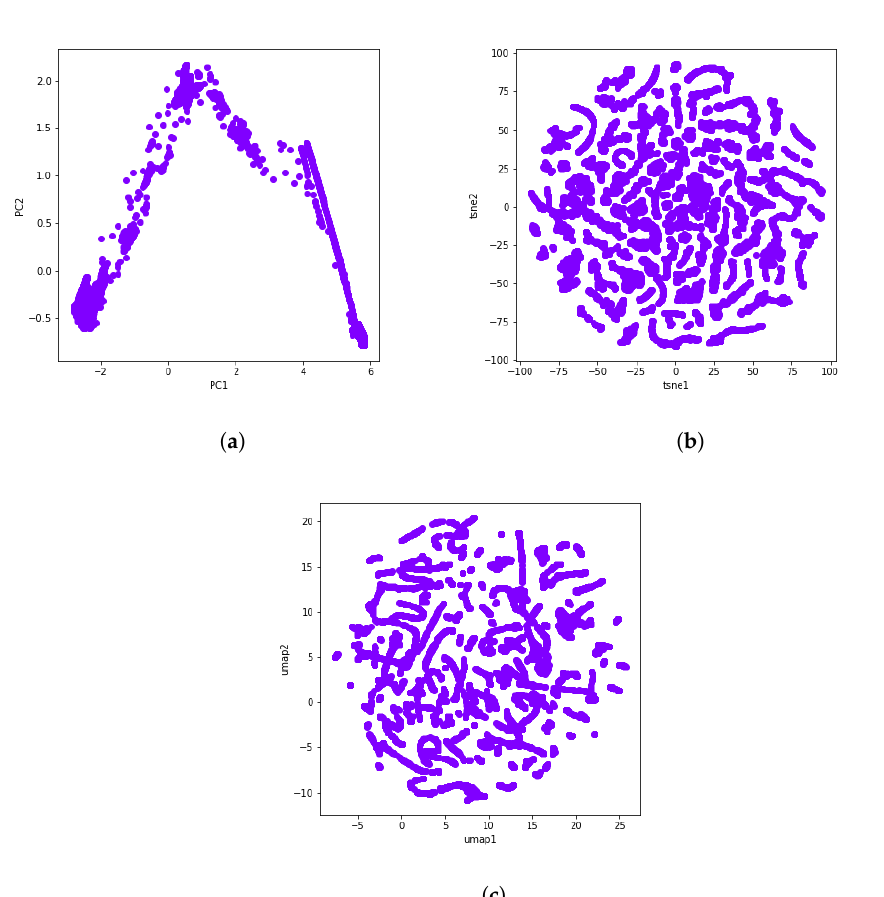
Figure 3. A visual representation of PCA, t-SNE, and UMAP through the use of data from the gas turbine GT281 during 16 days. ( a ) PCA. ( b ) t-SNE. ( c )